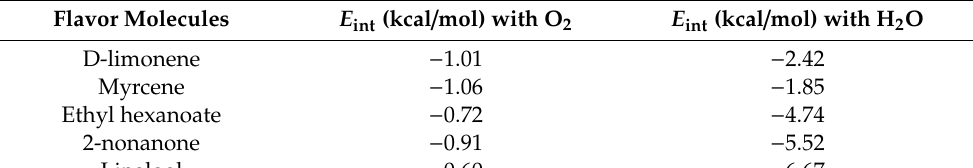
Table 9. Interaction energies between O 2 or H 2 O and flavor molecules.